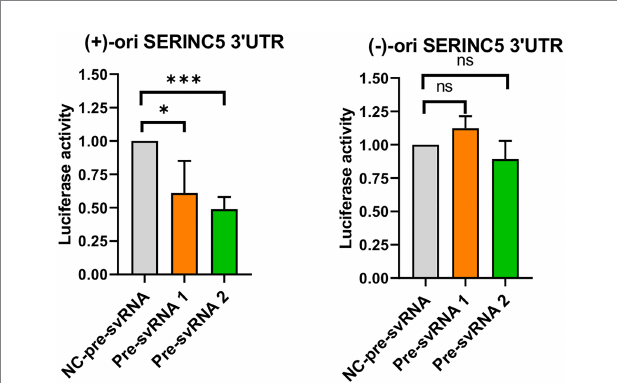
FIGURE 6 Study of the binding capacity of svRNA 1 and 2 to the 3’UTR of SERINC5 mRNA. Vero E6 cells were co-transfected with a negative control oligonucleotide (NC-pre-svRNA), the oligonucleotide mimic of svRNA 1 or 2 (pre-svRNA 1 and 2) together with the reporter constructs containing the Firefly Luciferase gene fused with the SERINC5-3 ′ UTR in the direct (+) (left panel) or reverse ( − ) direction (right panel), and the Renilla Luciferase control vector. At 48 h post-transfection the luciferase activity was analyzed and the data obtained were normalized to the levels of Renilla Luciferase (Control of transfection). Differences from control values were found to be statistically significant at * p < 0.05, ** p < 0.01, and *** p <